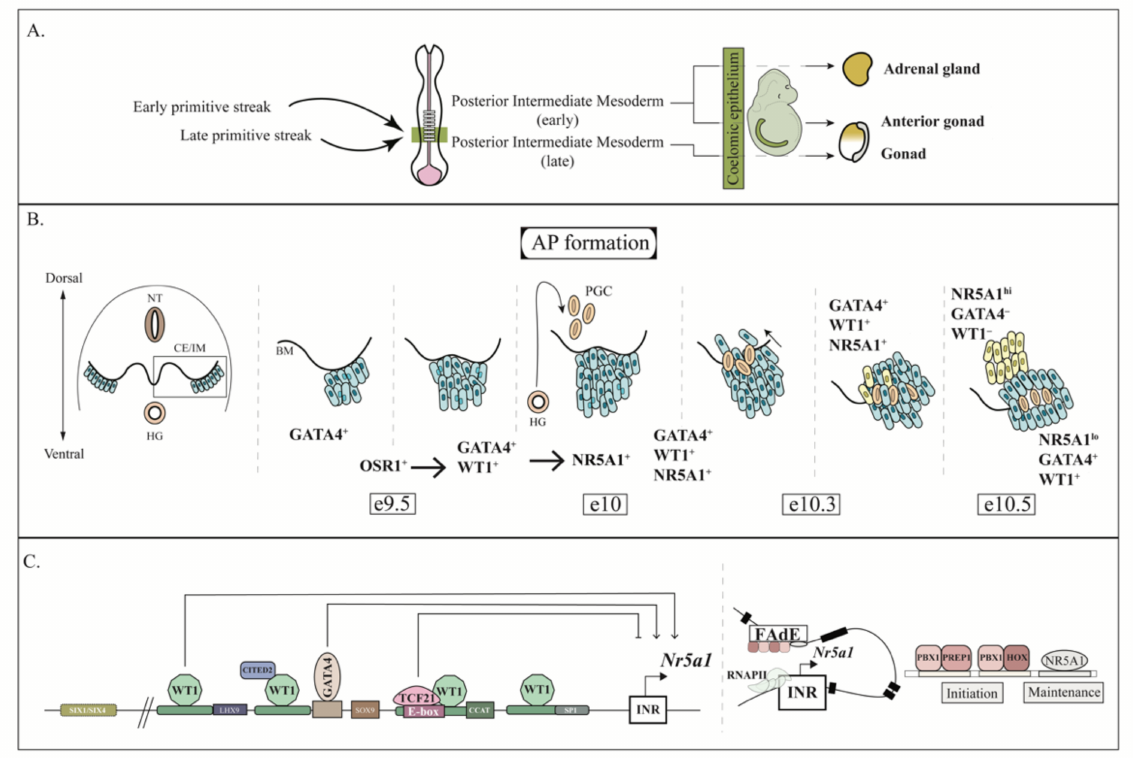
Figure 1. Key events in for the early stages of the development of the fetal adrenal cortex in mice: ( A ) Schematic model for the anterior–posterior regionalization of the posterior intermediate meso- derm, the coelomic epithelium and the AGP in mouse. Fate mapping experiments suggest that cells from the early (anterior) primitive streak migrate to form the early posterior intermediate mesoderm, which is followed by subsequent formation of both the adrenal and the gonad, while cells from the late (posterior) primitive streak migrate to form the late posterior intermediate mesoderm, which is followed by formation of the gonad but not the adrenal gland. ( B ) Schematic model for the develop- ment of the AP in mouse. The schematic representation of a transverse view of an embryo shows that the AGP arises from the thickening and delamination of the coelomic epithelium, a process that is initiated around 9.5 and that necessitates the contribution of GATA4 OSR1, WT1 and NR5A1. Once AGP is formed it is invaded by the PGCs (around e10.0), which leads to the separation of the AP from the GP (at e10.5 when a population of cells expressing high levels of NR5A1 begins to migrate dorsomedially). ( C ) Overview of the regulation of the transcription of Nr5a1 during AGP and AP formation. In the coelomic epithelium/AGP, Nr5a1 expression is initiated by the binding of several factors to its proximal promoter (only the transcription factors relevant to adrenal development are depicted). Elevated expression of Nr5a1 in the AP is initiated by the binding of PREP1, PBX1 and HOXs to the FadE enhancer located in the exon 4. Elevated expression of Nr5a1 in the AP is further maintained by an autoregulatory loop. AGP = adrenogonadal primordium, AP = adrenal primordium, BM = basement membrane. CE/IM = coelomic epithelium/intermediate mesoderm, FadE = fetal adrenal enhancer, GP = gonadal primordium, HG = hindgut, PGCs = primordial germ cells, NT = neural